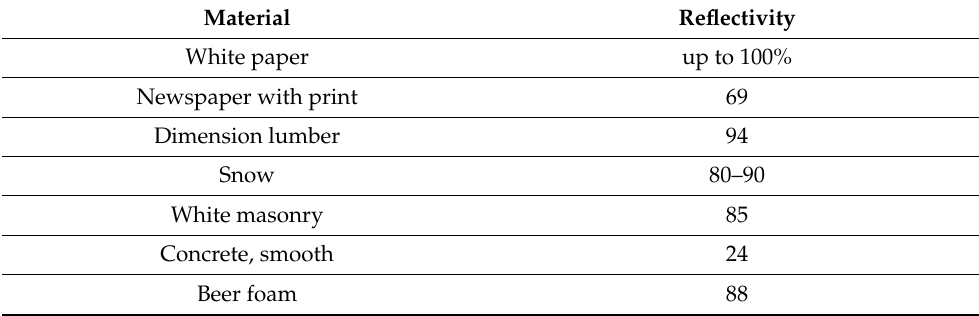
Table 1. Reflectivity of certain materials according to [29].